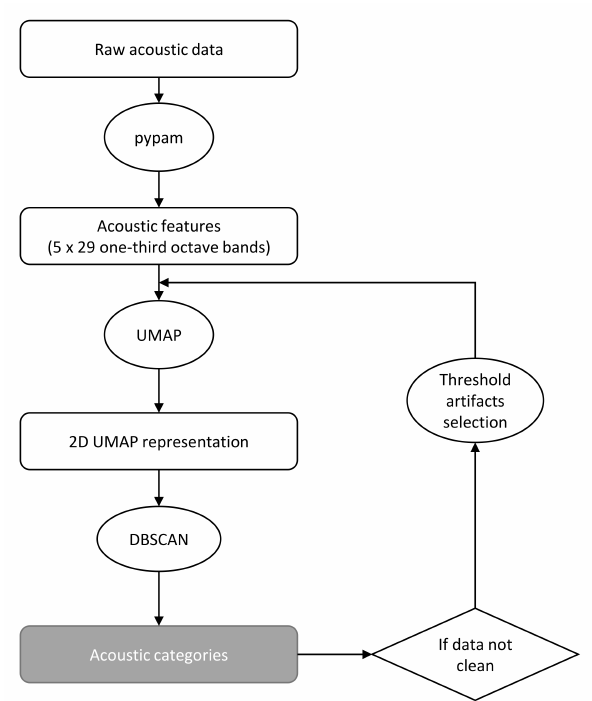
Figure 3. Flowchart to obtain the acoustic